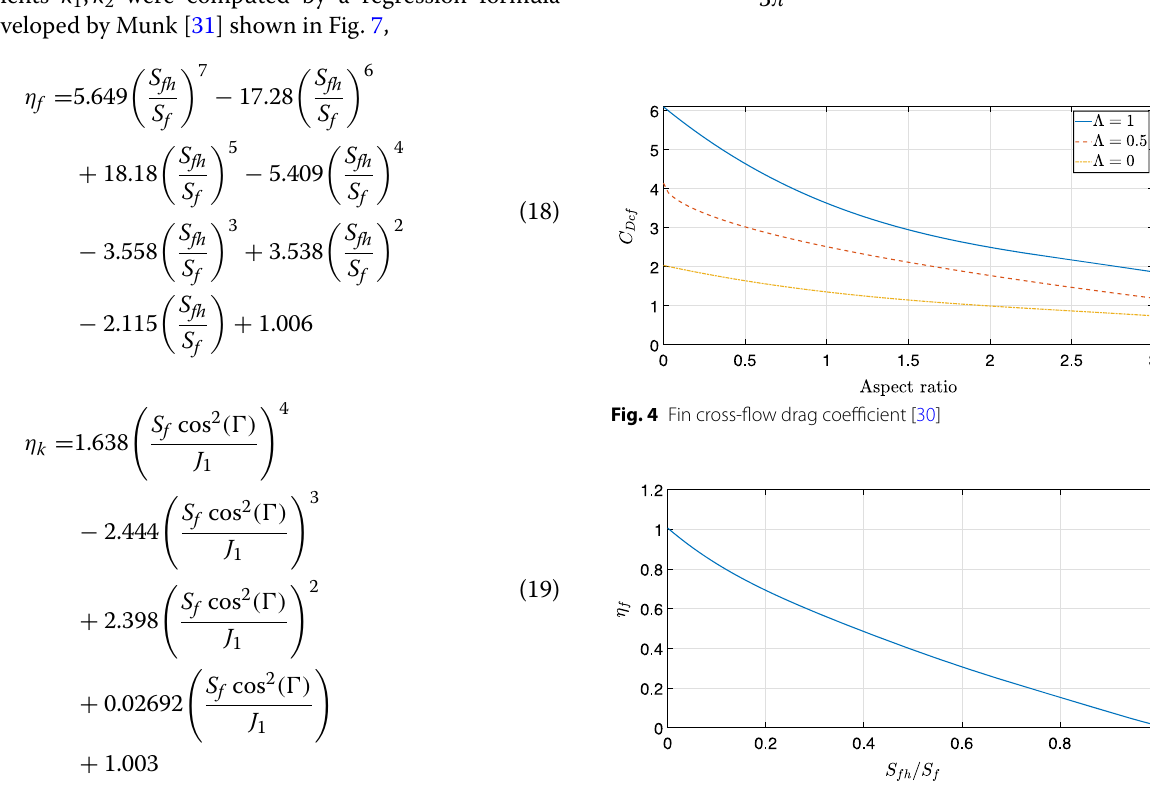
Fig. 5 Fin-efficiency factor η f